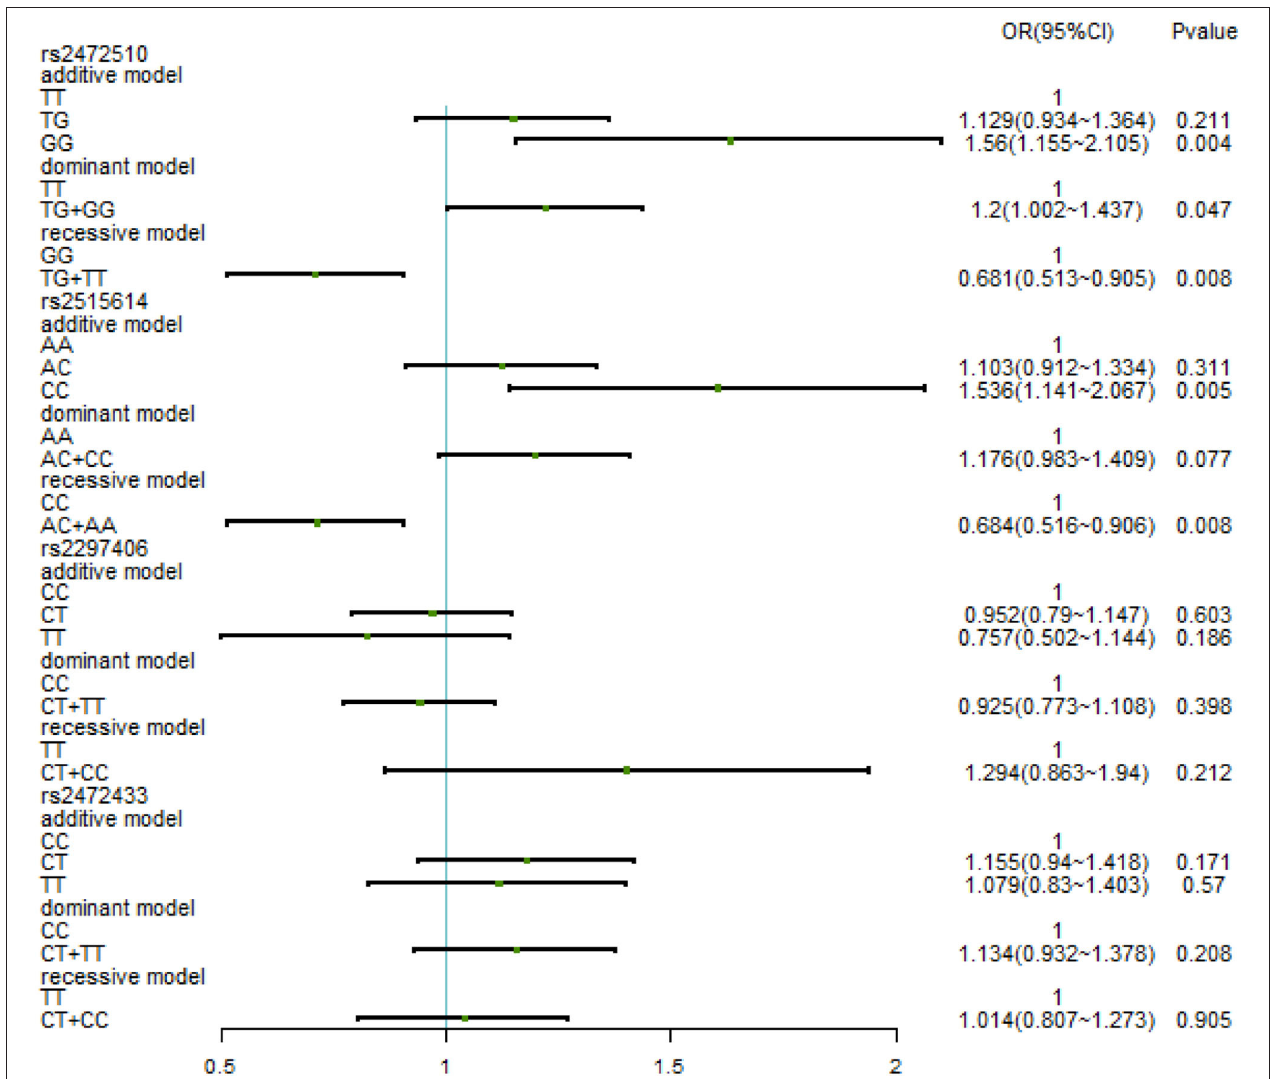
FIGURE 2 | Binary logistic regression analysis for the association between genotypes of rs2472510, rs2515614, rs2297406, rs2472433, and high